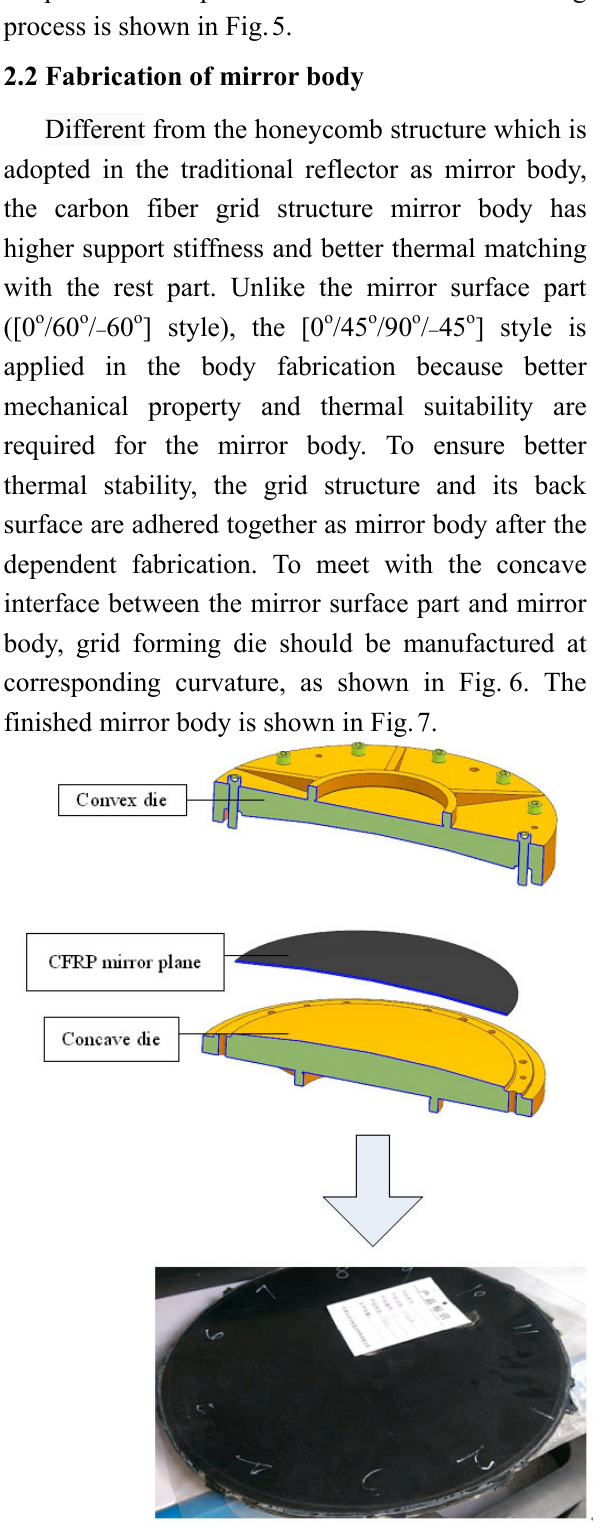
Fig. 5 Forming process of the